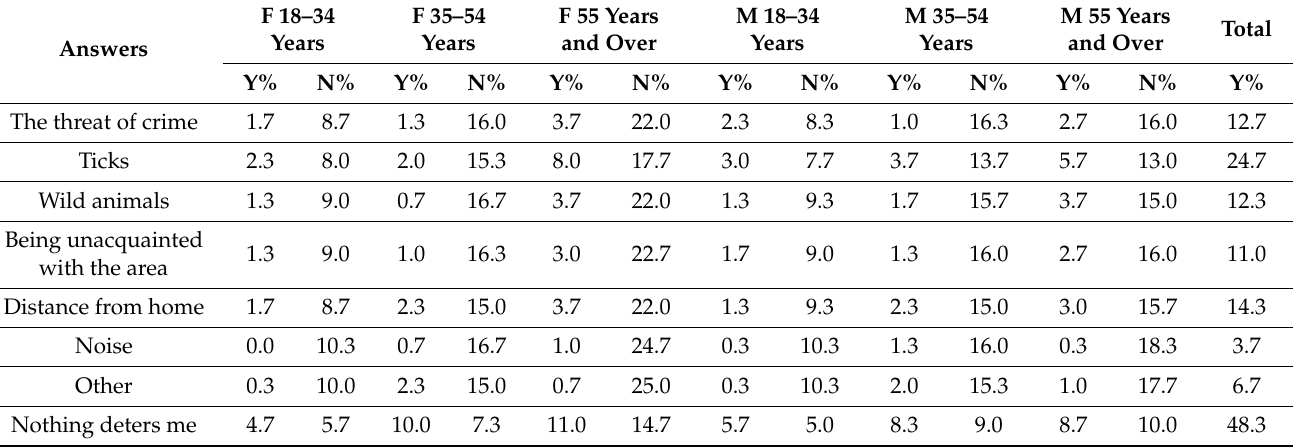
Table 7. Respondents’ answers (by sex and age) to the question: what deters you from wandering in a forest or park in the city? (Source: the